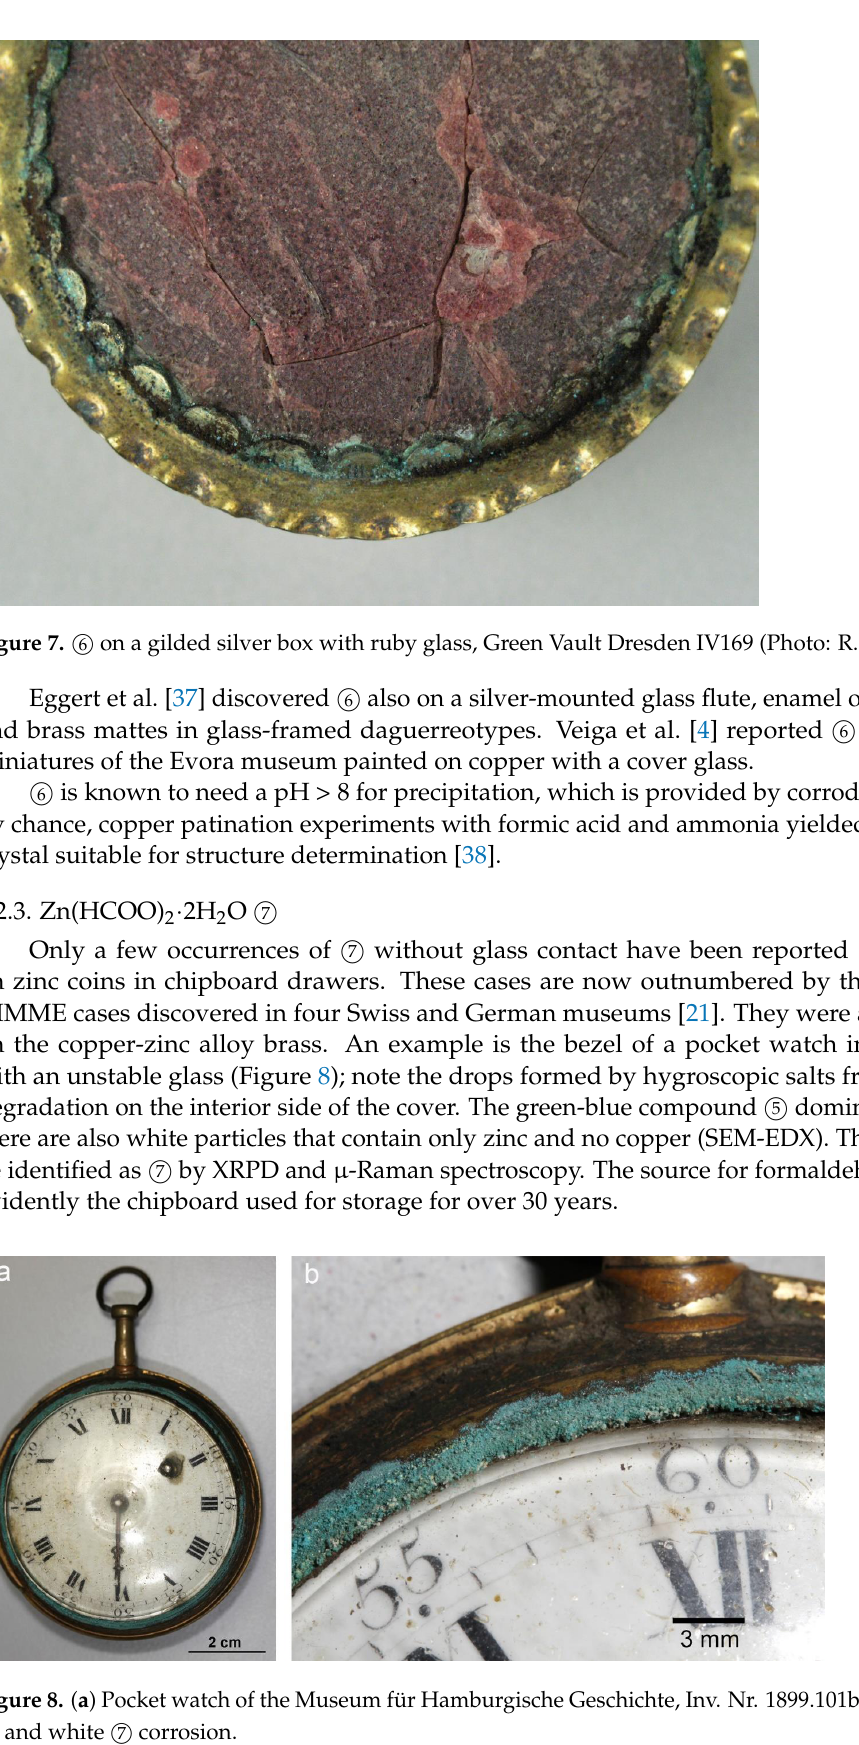
always multiphase. However, a pure sample could be obtained by corroding a brass (CuZn10) coupon dipped in aqueous potassium hydrogencarbonate at 76% RH with va- pours from 4% aqueous formaldehyde [21]. This pure sample allowed the determination of the crystal structure [22] with different crystallographic sites for the cations. An octa- hedral site can be occupied either by zinc or copper which makes the stoichiometry some- what flexible. The compound was detected on 12 objects of various types. A metal clamp holding a reagent tube showed that GIMME can also be found on 20th century objects (Figure 9). Figure 9. ( a ) Reagent tubes held by metal clamps to display plant remains in the Institute of Plant Biology Zurich; ( b ) corrosion on a metal clamp. (Photo: HE-Arc CR). 3.3. Uncharacterised Compounds Because of a lack of suitable samples of pure and ideally crystalline material there are still a number of GIMME compounds waiting for their full characterisation [3]. They con- tain Na, K, Cu, and/or Zn (EDX-SEM) and are often carboxylates (Raman). One example is the corrosion product of the enamel of a procession cross in the British Museum (K, Cu, and formate). As it was also found in simulation experiments [14], it might be possible to obtain sample material for further studies in the future. The crystalline compound labelled Zinc A contains zinc and sodium and possibly a little copper and is most likely an acetate